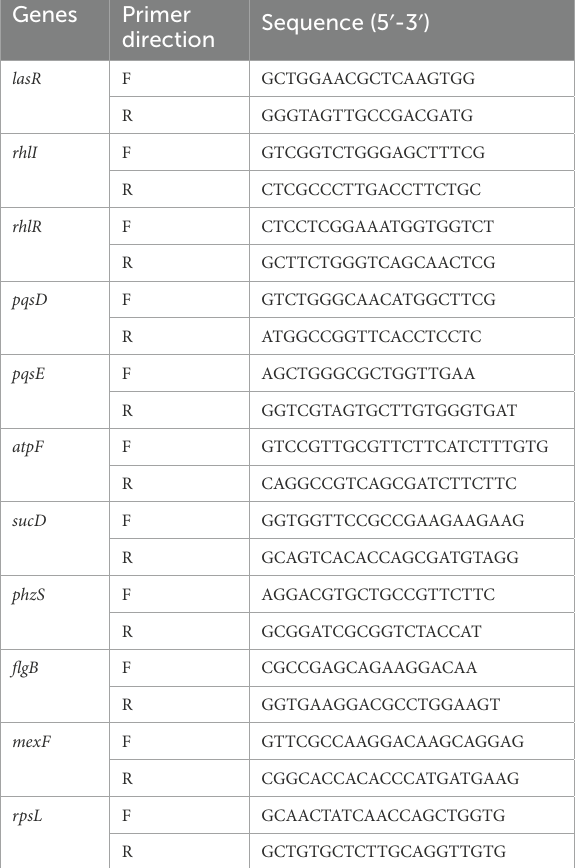
TABLE 1 PCR primers for qRT-PCR.